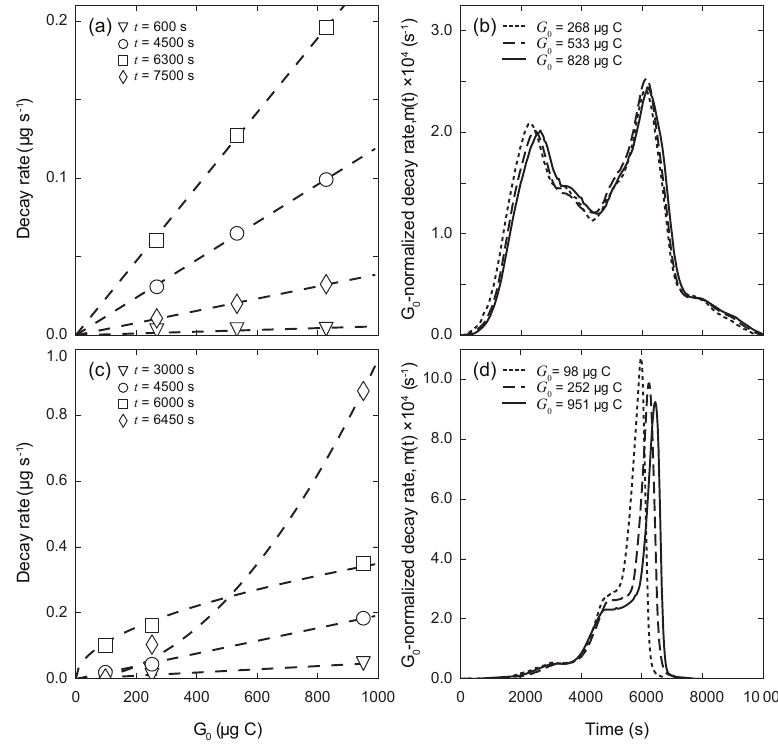
Figure 4. First-order kinetic assessment. Panels (a) and (c) show decay rate, d G(t)/ d t , vs. G 0 relationships at four arbitrarily chosen time points (including best-fit regression lines, dashed lines) and panels (b) and (d) show the mass-normalized decay rates (termed m(t) in Eqs. 24– 25) at all time points for (a) – (b) Narayani POC and (c–d) JGOFS sediment. Linear relationships and nearly identical normalized decay rates in panels (a–b) confirm the first-order nature of OC decay, while nonlinear relationships and a shifting carbonate peak in panels (c–d) indicate non-first-order CaCO 3 decay kinetics. For each time point in panel (a) , the regression slope is equivalent to m(t) for that time point as shown in panel (b)